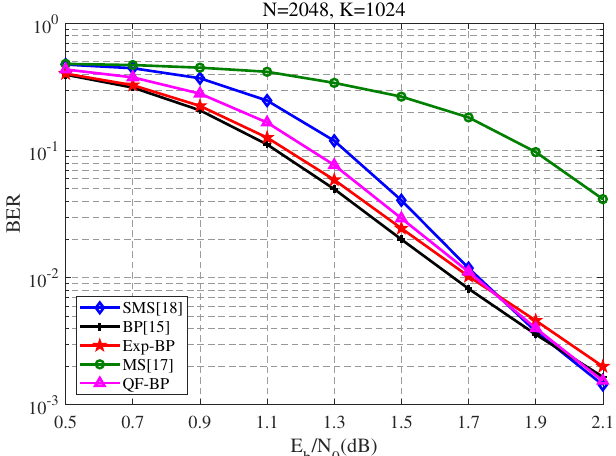
Figure 4. The BER performance of different algorithms with N =